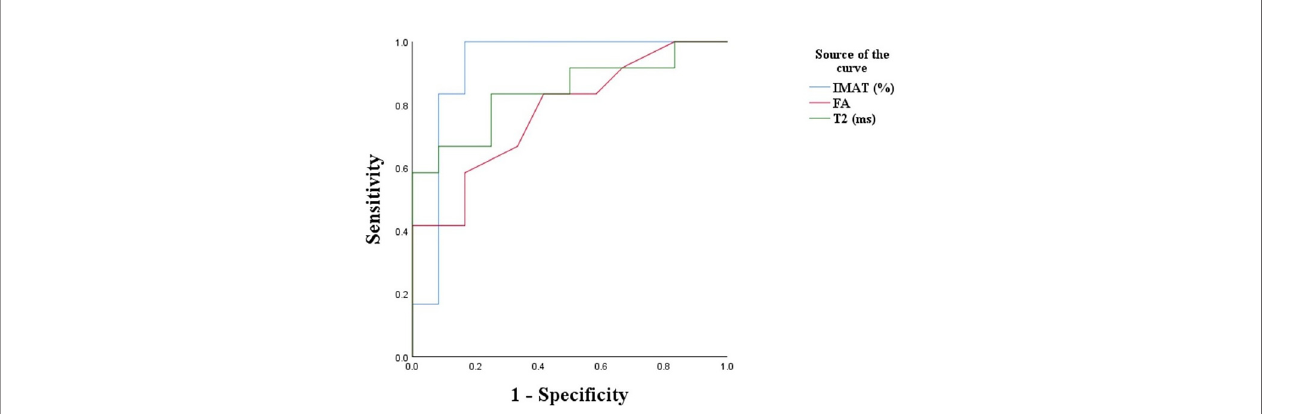
FIGURE 3 | ROC plot of each type of indicator for diagnosis of type 2 diabetes. IMAT, intermuscular adipose tissue; FA, fractional anisotropy; T2, transverse